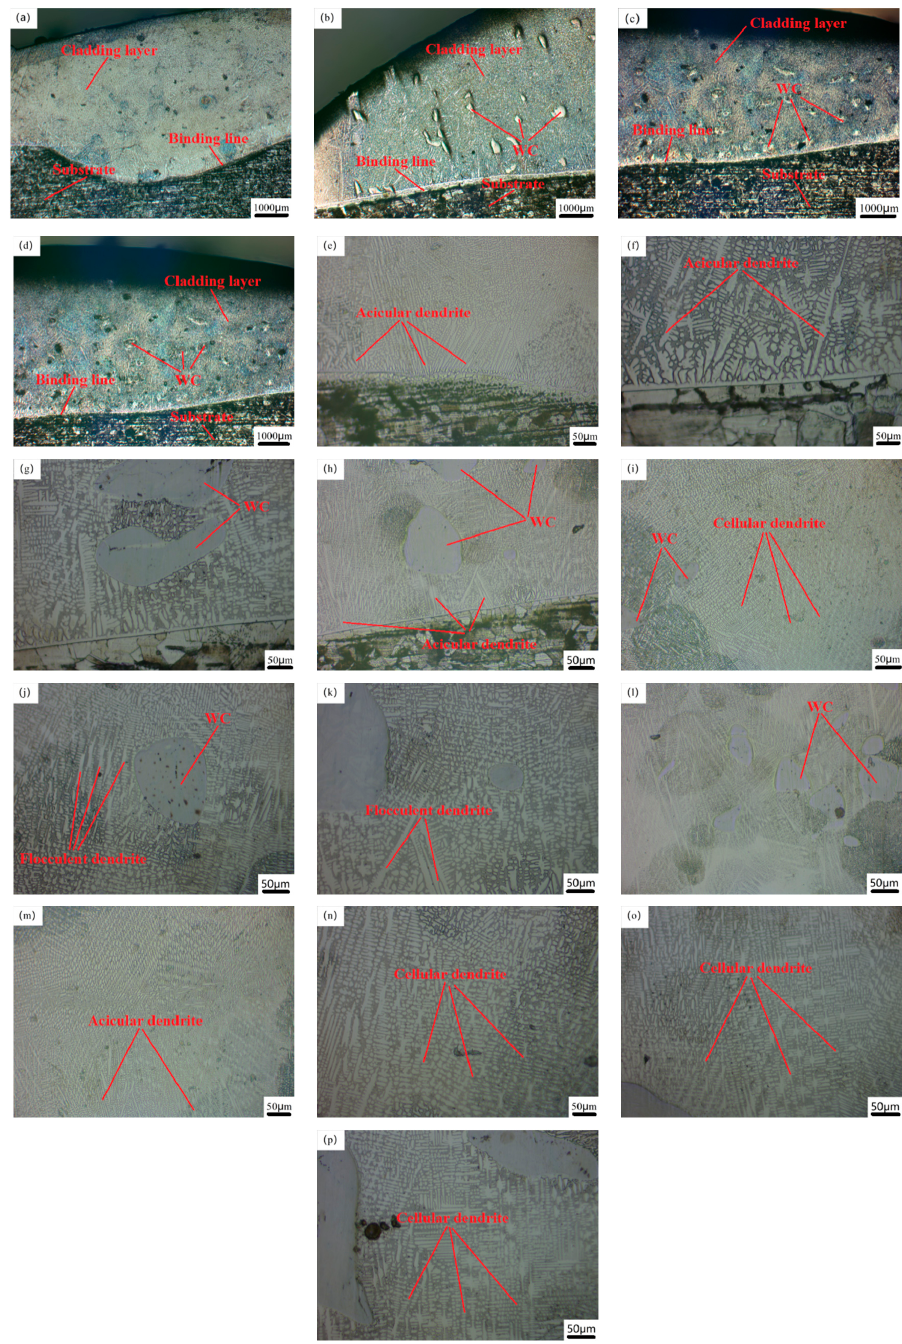
Figure 3. Metallographic diagram of Co-Cr-WC composite cladding layer. ( a , e , i , m ) Co-Cr; ( b , f , j , n ) Co-Cr-10%WC; ( c , g , k , o ) Co-Cr-30%WC; ( d , h , l , p ) Co-Cr-40%WC. As shown in Figure 4, the SEM images of the cross-sectional joint area, the middle and the top area of the cladding layers of the samples N1, N3, and N4, respectively, are shown. From the micro-SEM image of the whole section of the cladding layer in the figure, it can be seen that the sizes of dendrites in different parts of the cladding layer of the sample are significantly different. It is because during the solidification process of the molten pool, the temperature gradient of different positions has different solidification rates, and the temperature of the molten pool decreases from the bonding area to the top of the cladding layer, as shown in Figure 4d,e,g. As shown in Figure 4h, the crystal state of the middle and top regions of the cladding layer is compared, so the dendrite matrix in different positions has different nucleation and growth rates, and the temperature in the